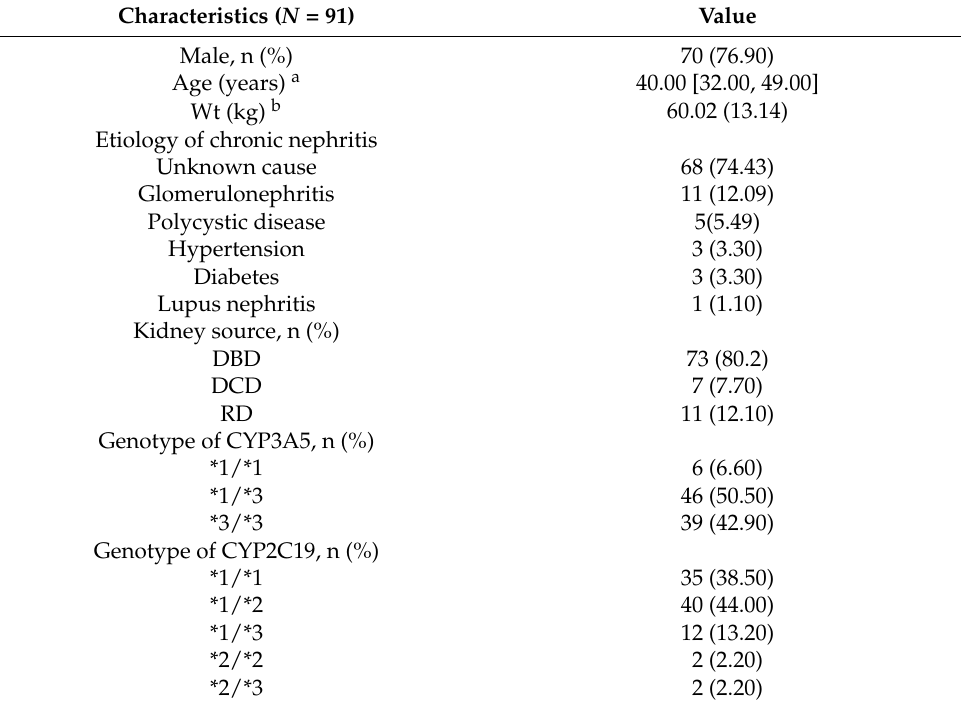
Table 1. Distribution of kidney sources and genotypes of patients.